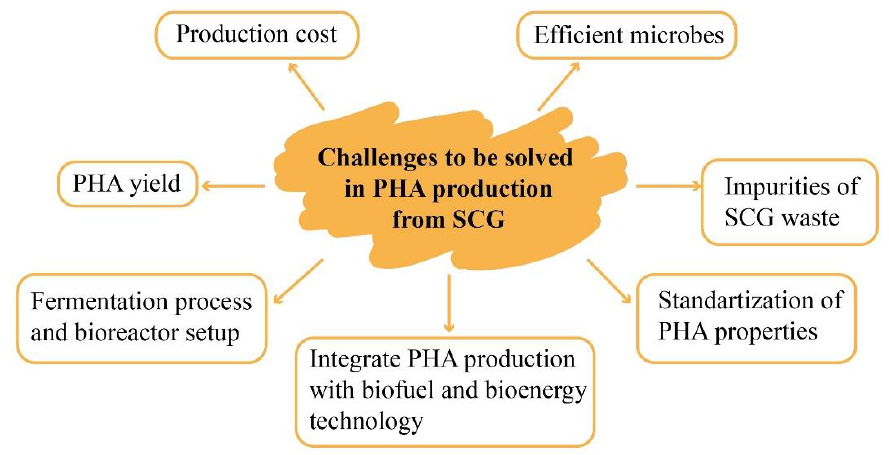
Figure 4. Challenges related to PHA production from SCG.